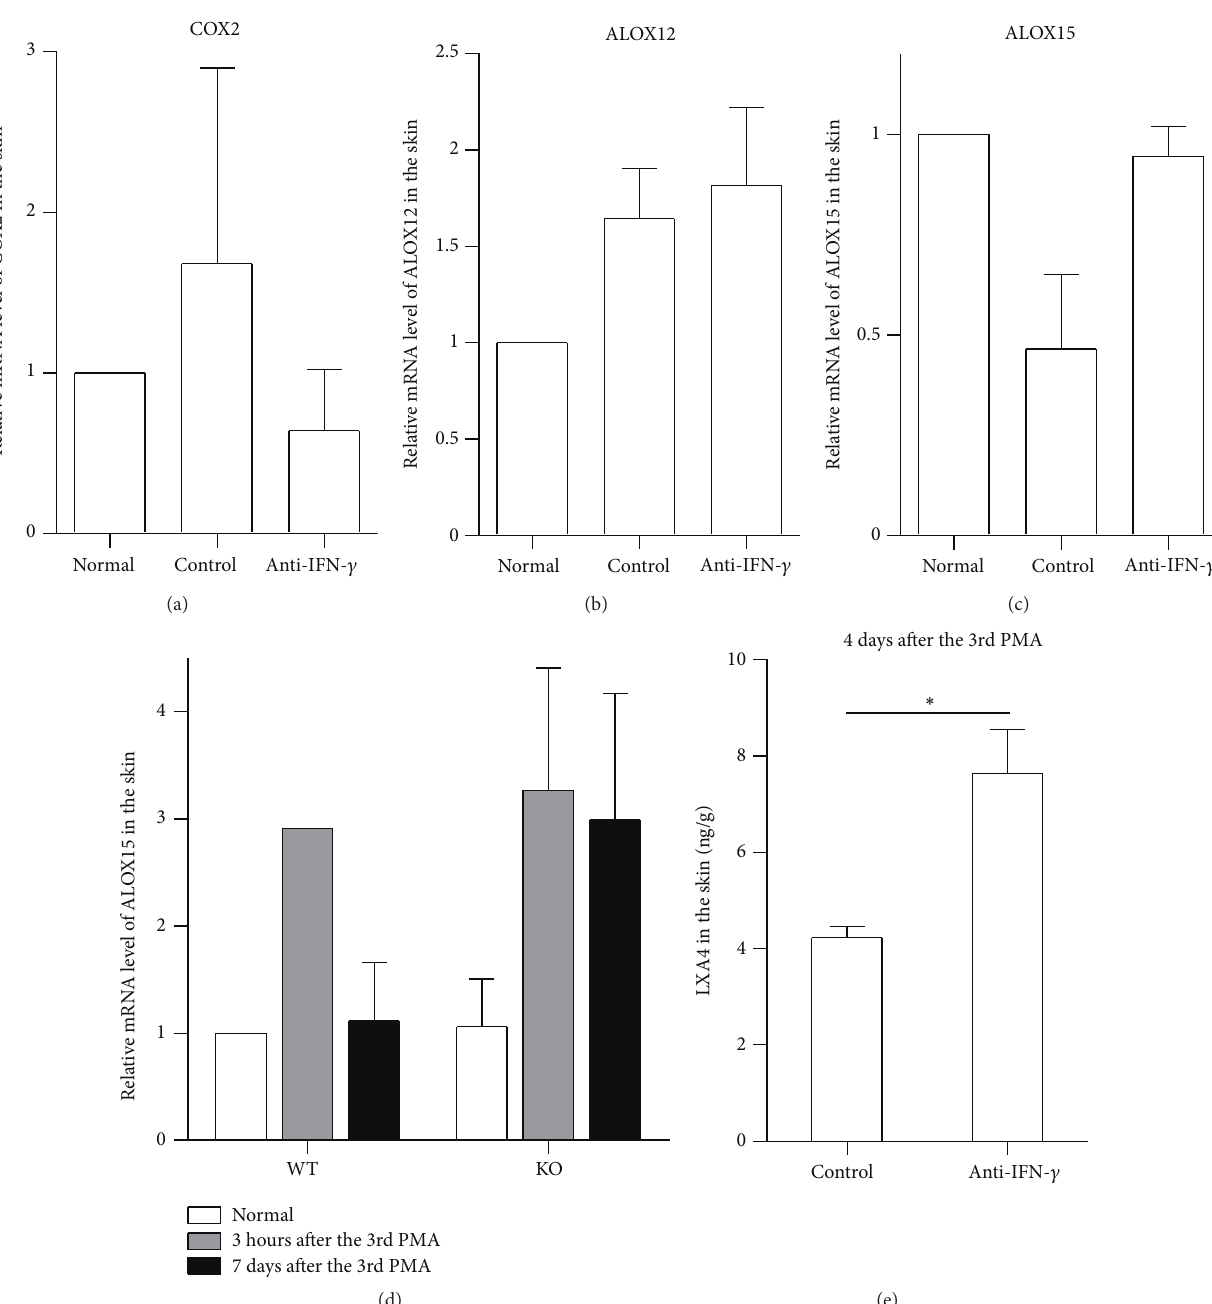
Figure 4: Neutralization of endogenous IFN- 𝛾 promoted the ALOX15 expression of the skin. Mice from control or anti-IFN- 𝛾 group were sacrificed 4 days after the third PMA painting. The skin was removed, and the mRNA level of COX2 (a), ALOX12 (b), and ALOX15 (c) was detected by real-time PCR. (d) IFN- 𝛾 R knockout (KO) and wild-type 129/Sv/Ev (WT) mice were sacrificed 3 hours or 7 days after the third PMA treatment. The mRNA level of ALOX15 in the skin was measured by real-time PCR. (e) The levels of LXA4 in skin of control and anti-IFN- 𝛾 groups 4 days after 3 times PMA treatment were detected by ELISA. ∗ 𝑃 < 0.05 . comparison with that in control mice. BOC2 application in IFN- 𝛾 -neutralized mice elevated the MCP-1 expression to the same level as that in control mice (Figure 5(b)). All these results indicate that blockage of IFN- 𝛾 promoted skin inflammation resolution through an ALOX15-LXA4- associated